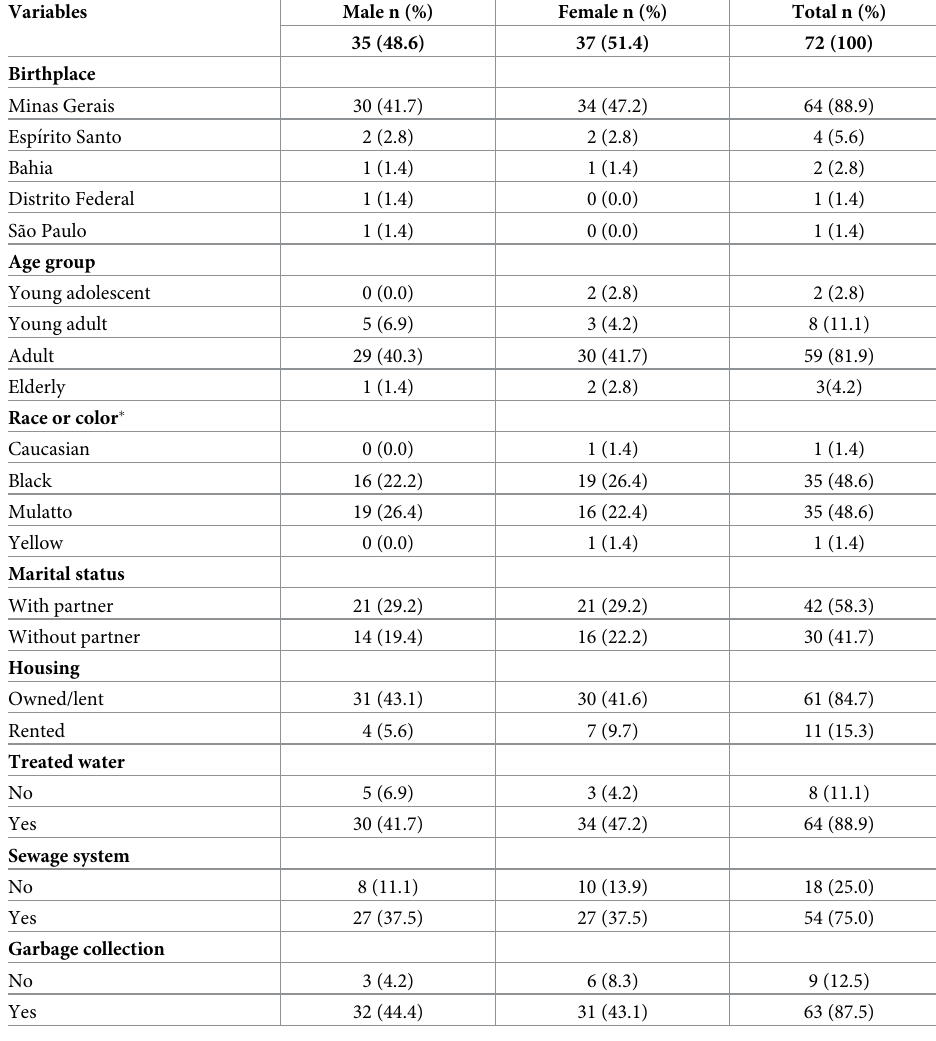
Table 1. Sociodemographic variables, by sex (n =